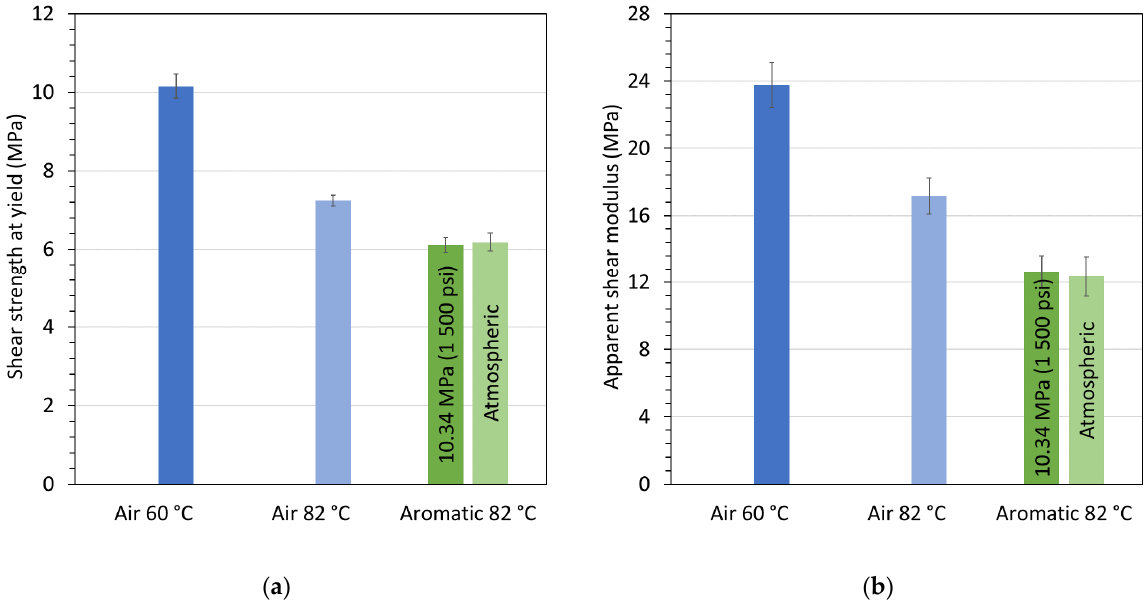
Figure 6. ( a ) Shear strength at yield and ( b ) apparent modulus for Polymer A2 conditioned and tested in air at 60 °C and 82 °C and in aromatic fluid at 82 °C and atmospheric and 10.34 MPa (1500 psi) pressure.